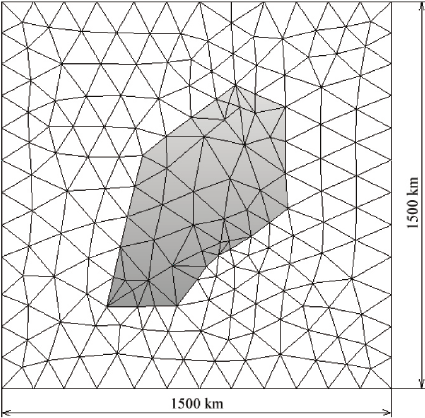
Fig. 1. Finite element meshing of the